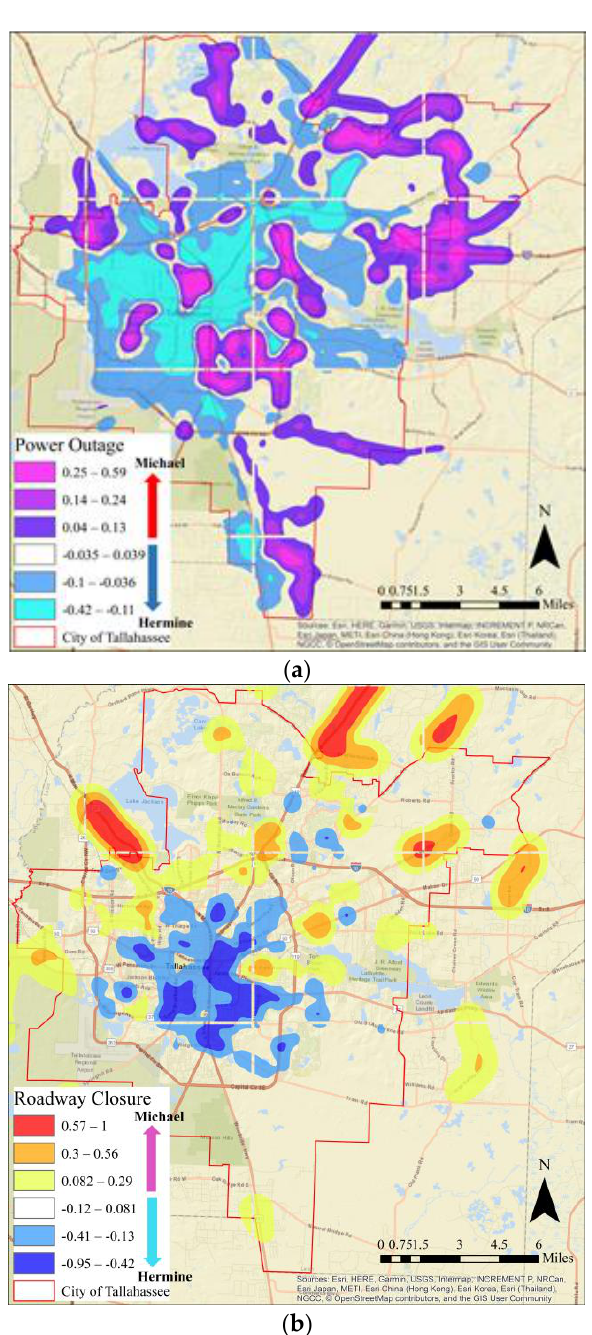
Figure 6. Density ratio difference between Michael and Hermine: (a) power outages; (b) roadway closures. Note that for power outages, higher densities of power outages caused by Michael are indicated in purple. For those areas with more cyan color, on the other hand, Hermine caused more damages than Michael. Similarly, for the roadways, more red areas indicate those that Michael affected more than Hermine, whereas the opposite is valid for more blue areas.